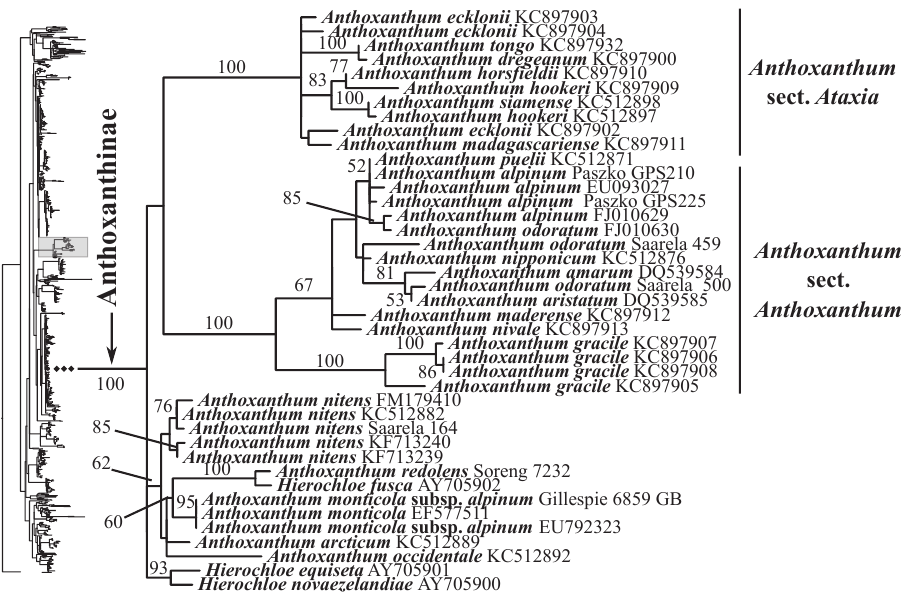
Figure 13. A portion (Anthoxanthinae) of the maximum likelihood phylogram inferred from ITS data. ML bootstrap support is recorded along branches when >50%. The shaded area of the smaller tree on the left indicates the location in the overall tree of the portion shown. The backbone branch represented by ellipses is shown only in Fig.